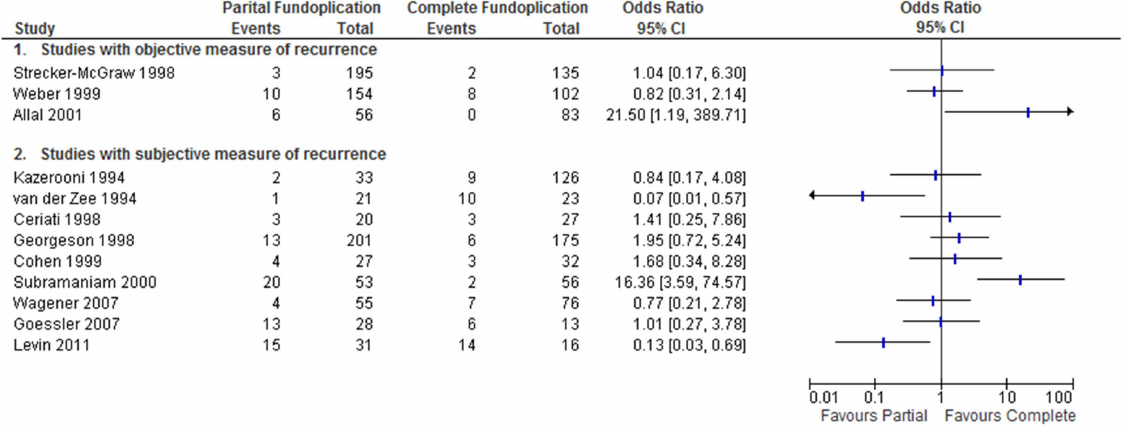
Figure 3. Recurrence of GERD following partial versus complete fundoplication (observational studies).